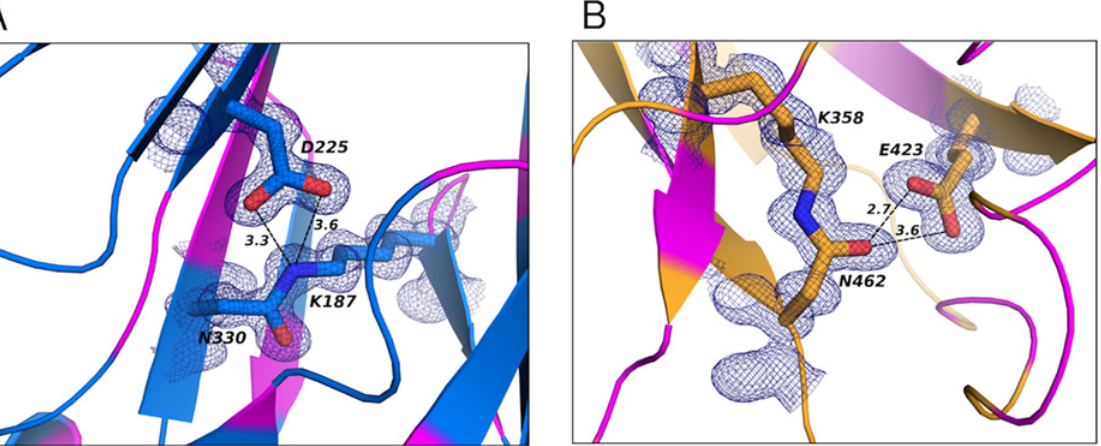
Fig 2. Isopeptide bonds of BP-2b. Domains D2 and D3 are colored as in Fig 1 in blue and orange, respectively. Isopeptide bonds between Asn330 and Lys 187 for D2, and between Asn462 and Lys358 in D3 are shown with blue and orange sticks, and 1 σ 2 F o- F c electron density map around this region is shown as blue mesh (carve = 1.1). The magenta colored regions in (A) and (B) show the location of hydrophobic residues surrounding the isopeptide bonds. Hydrogen-bonds between the isopeptide bonds and the nearby Asp (225, D2) and Glu (423, D3) are shown with black dashed lines.